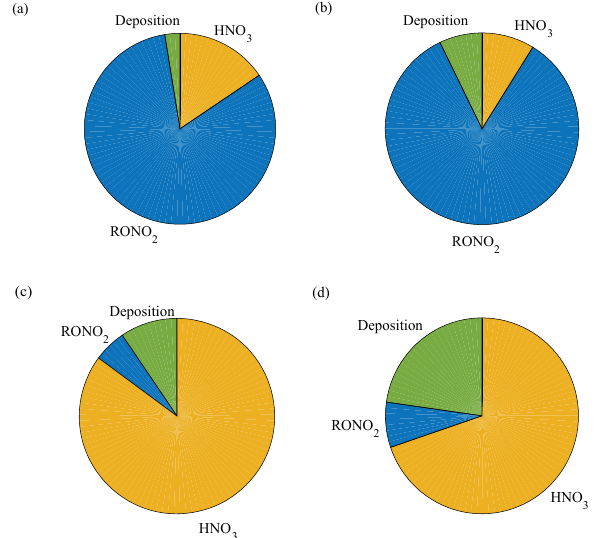
Figure 5. Model predictions of the fraction of NO x loss to alkyl nitrate formation, nitric acid formation, and deposition in a Q. agri- folia woodland. The model was run using scenarios with only soil emissions and LAI of 1m 2 m − 2 (a) , only soil emissions and LAI of = 10ppb and LAI of 1m 2 m − 2 (c) , and 3m 2 m − 2 (b) , C NO x ( adv ) = 10ppb and LAI of 3m 2 m − 2 (d) . C NO x ( adv )